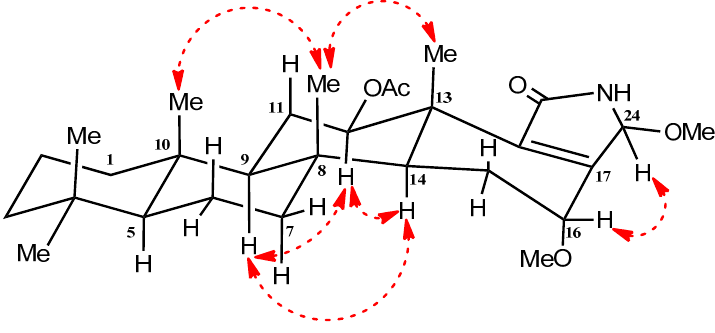
Figure 3. Important NOESY NMR correlations of compound 1 .